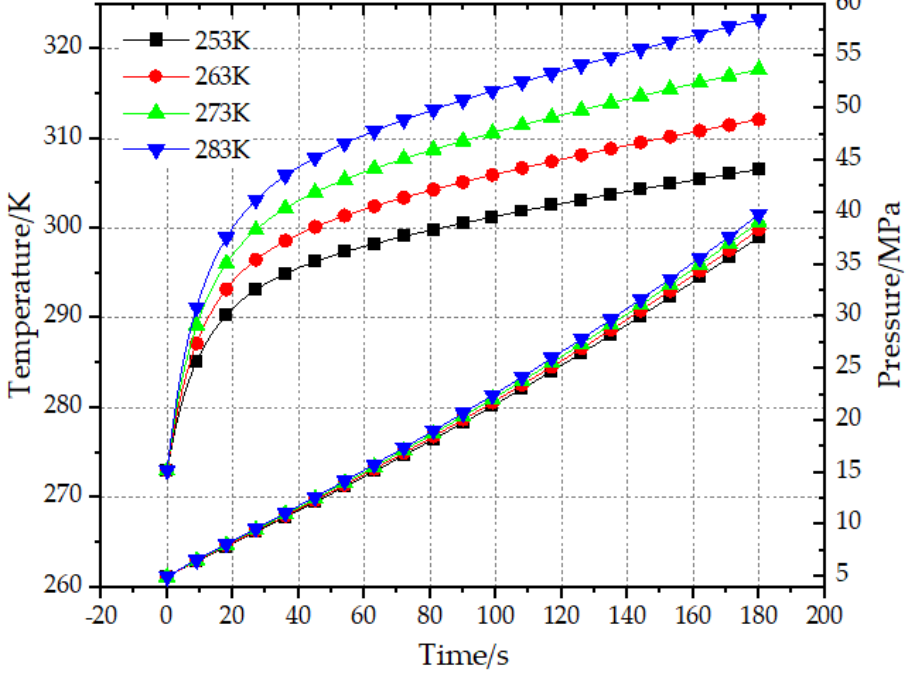
Figure 11. Effect of filling temperature on the temperature and pressure revolution.